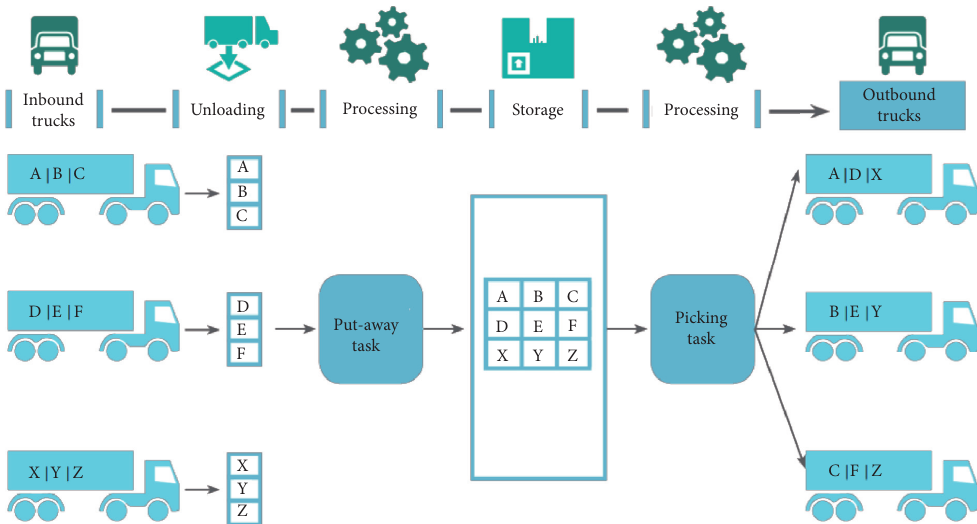
Figure 2: Schematic diagram of urban e-commerce logistics cooperative distribution